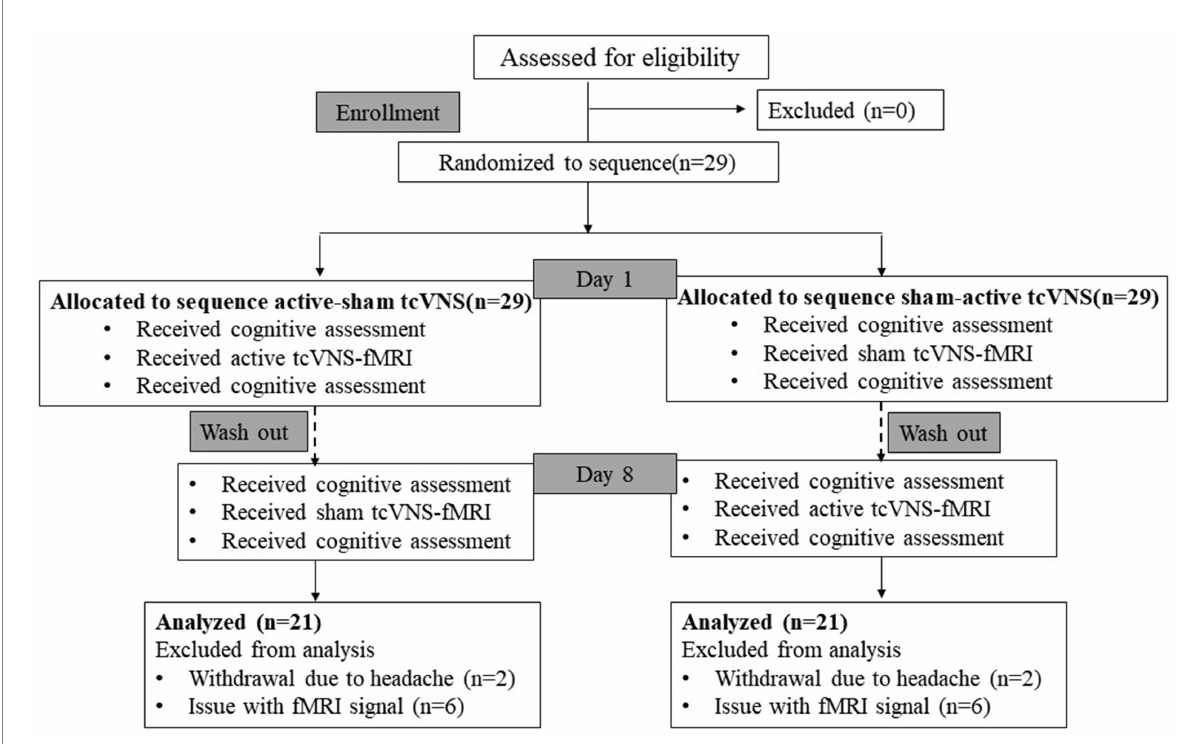
FIGURE 1 Diagram of the study. tcVNS, transcutaneous cervical vagal nerve stimulation; fMRI, functional magnetic resonance